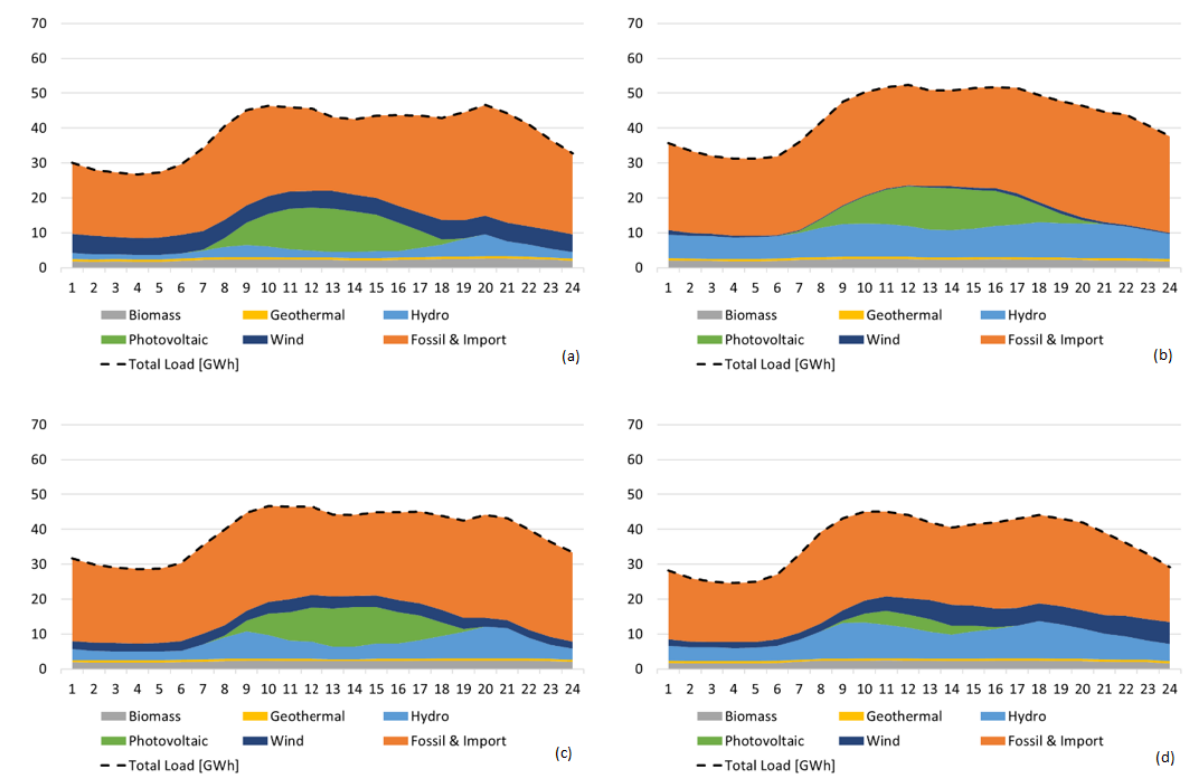
Figure 2. Energy mix for the electric energy supply on ( a ) 21 March, ( b ) 21 June, ( c ) 20 September and ( d ) 20 December 2019.